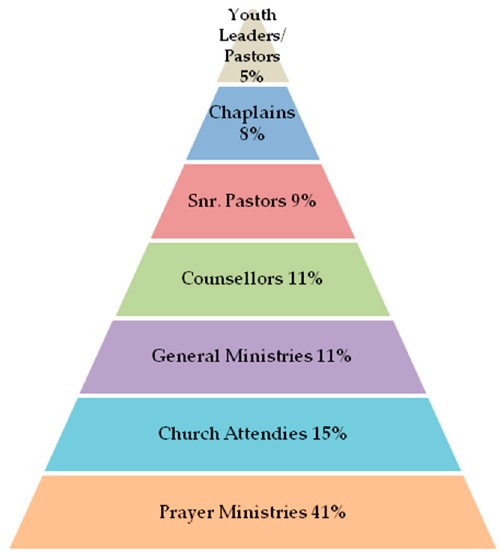
Figure 2. Combined ministries as percentages.